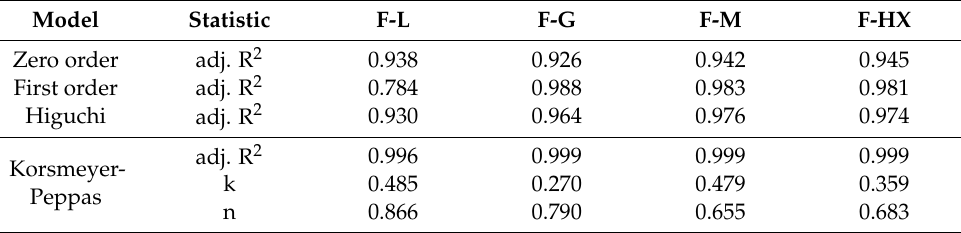
Table 6. Mathematical release model fitting and corresponding statistics for all formulations in phosphate buffer (pH 6.8). Note: For the Korsmeyer-Peppas model only the first 60% of the release curves ( n = 3) was used for statistical analysis. k = constant for the apparent velocity of dissolution, n = diffusional exponent indicating the drug release